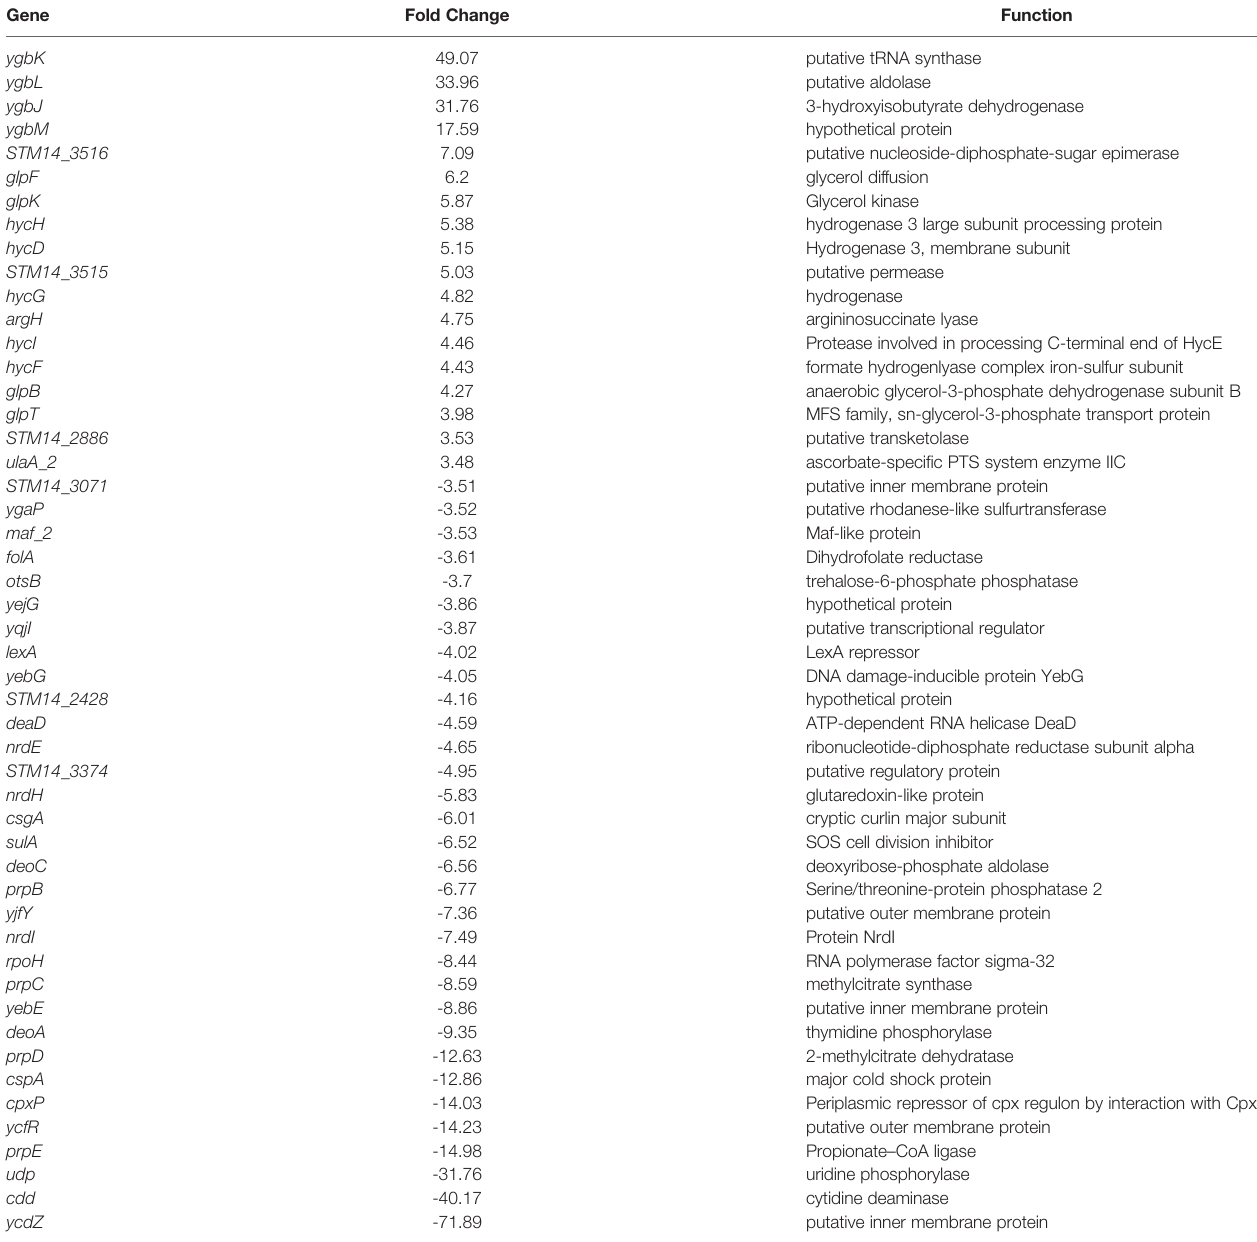
TABLE 3 | Top differentially regulated genes in D araE bio fi lms grown in 40 mM L-Arabinose compared to WT 5 mM L-Arabinose by RNA-Seq. Gene Fold Change Function ygbK 49.07 putative tRNA synthase